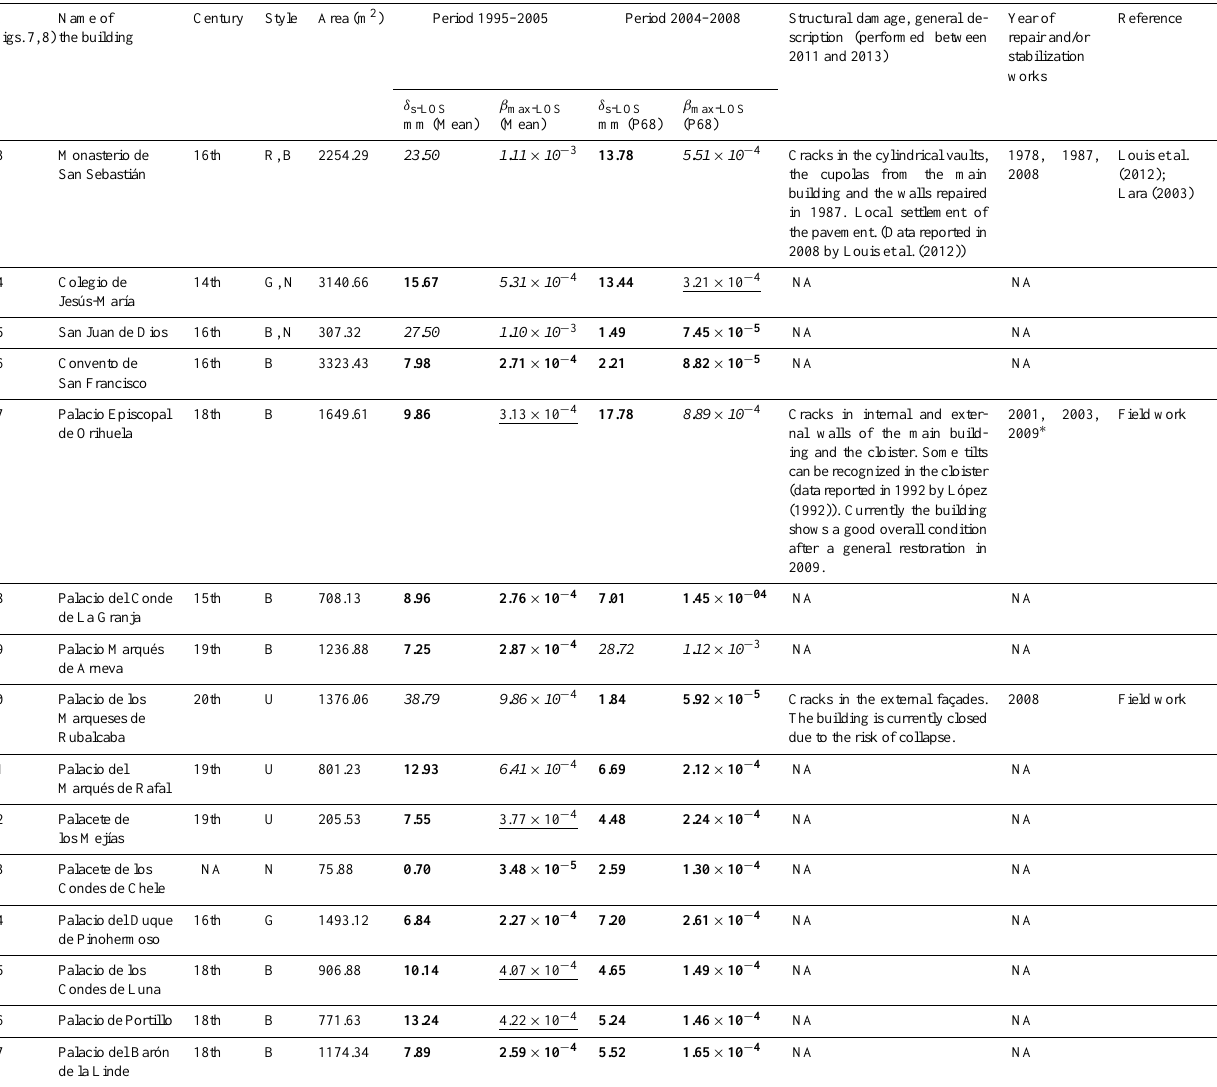
due to the risk of